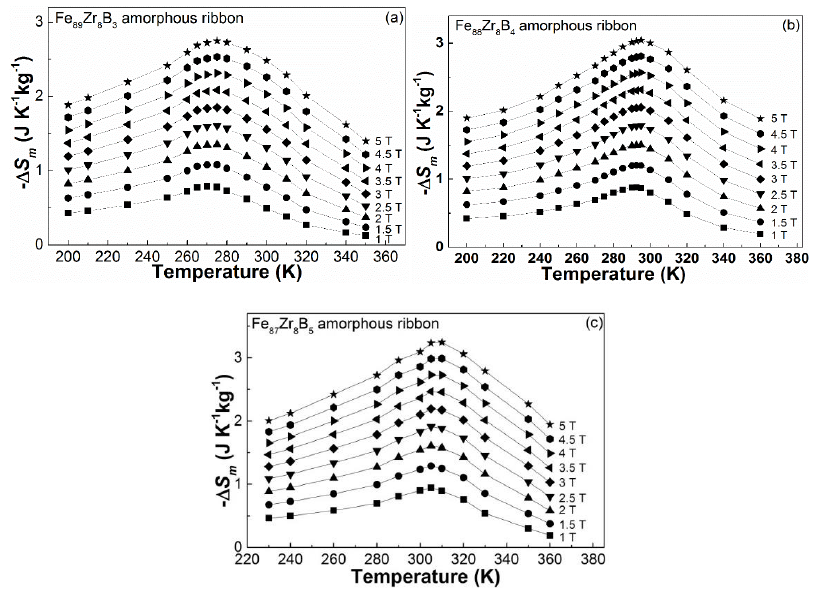
Figure 5. −Δ S m - T curves of the Fe 92-x Zr 8 B x (x = 3, 4, 5) amorphous ribbons under various magnetic Figure 5. − ∆ S m - T curves of the Fe 92 − x Zr 8 B x (x = 3, 4, 5) amorphous ribbons under various magnetic fields: ( a ) x = 3, ( b ) x = 4, and ( c ) x = 5. fields: ( a ) x = 3, ( b ) x = 4, and ( c ) x =